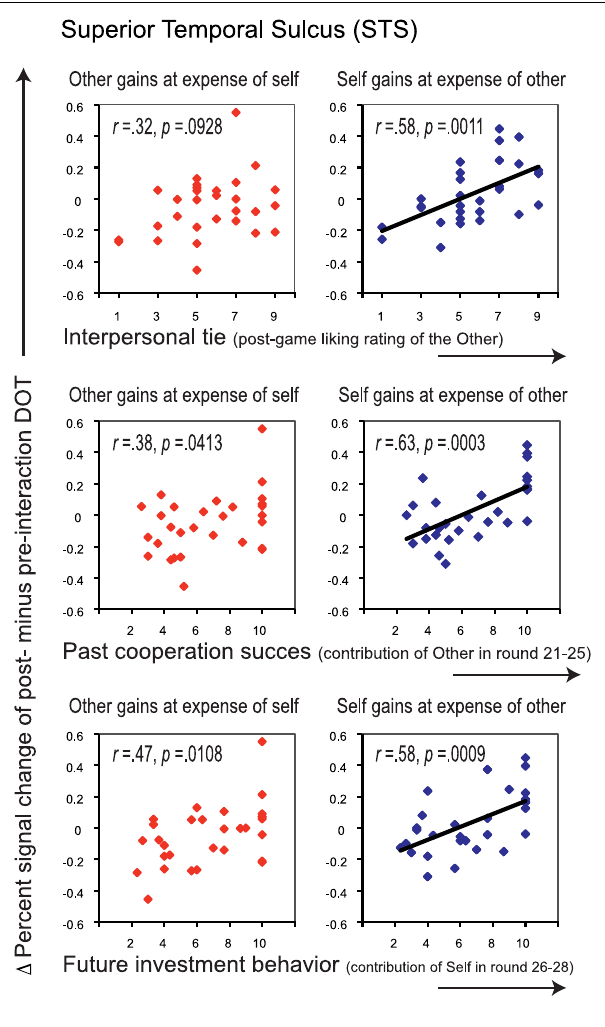
FIGURE 5 | Correlations between interpersonal tie-scores (top), past cooperation success (middle) as well as future investment behavior (bottom), and Δ percent signal change of post- minus pre-interaction DOT. Correlations are shown for the pSTS, for trials in which the other gains at the expense of oneself (left panels, in red), and for those in which oneself gains at the expense of the other (right panels, in blue). Correlations before and after public good game interaction separately can be found in Figure 6 . All correlations are listed in Table 4 .